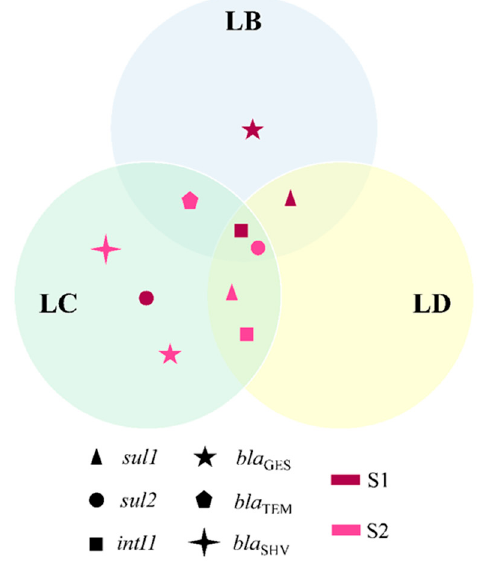
Figure 1. Presence of resistance genes in the studied ponds. Resistance genes are represented by geometric figures—dark pink in S1 and light pink in S2—in a Venn diagram. S1 and S2 correspond to the sampling period: high (S1; on 14 March 2019) and low monthly rainfall (S2; on 25 November 2019).